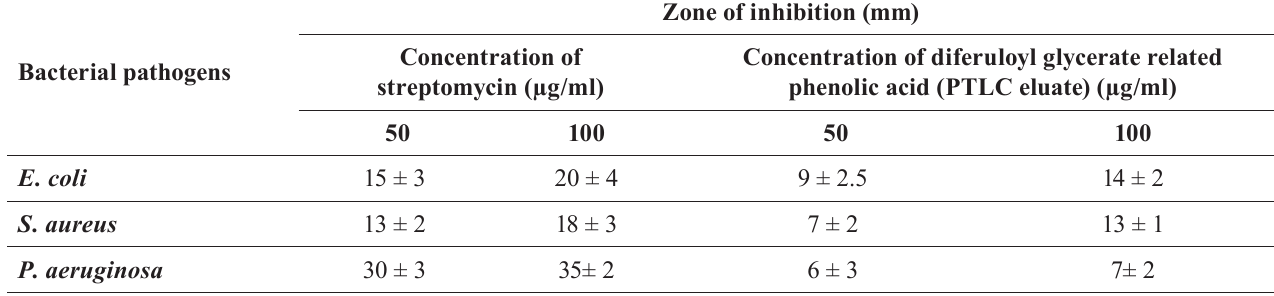
TABLE I - A ntibacterial activity of purified diferuloyl glycerate related phenolic acid and streptomycin (positive control) against DFU causing pathogens (clinical isolates)